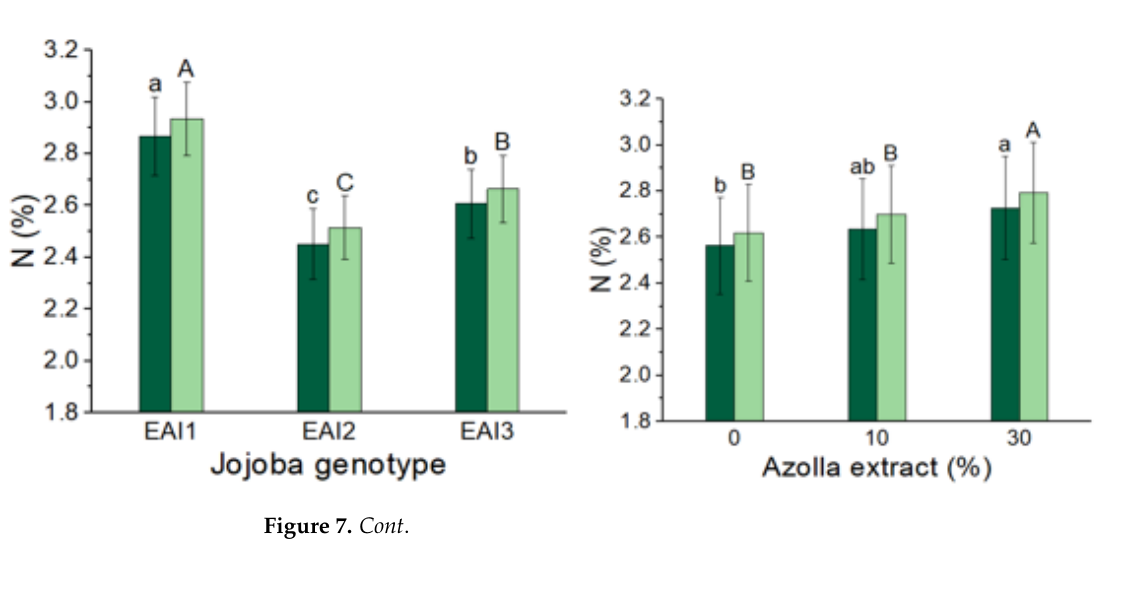
Figure 7. In both seasons, the mean values of nitrogen (%), phosphorus (%), and potassium percent- age (%) of jojoba shrubs were modified by plant genotypes and foliar application of Azolla filiculoides Lam. plant extract respectively. The data are expressed as a mean value ± SE. at the 0.05 level, bars with identical letters are not significant.